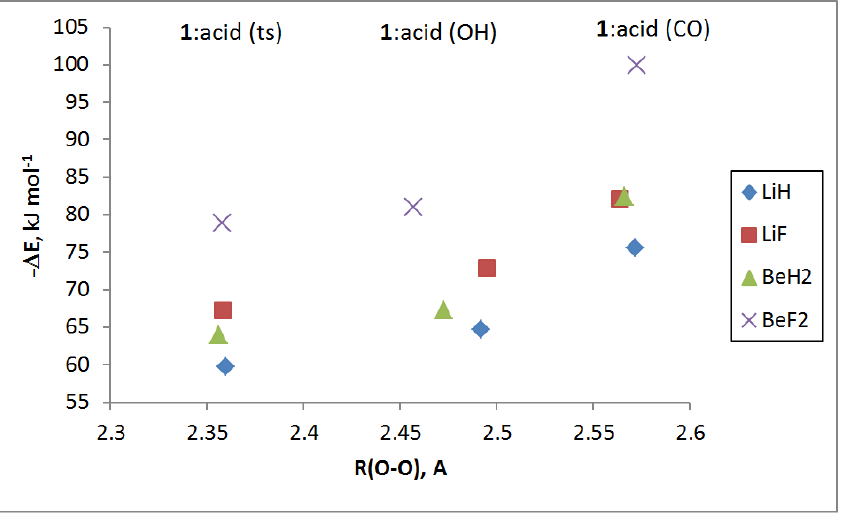
Figure 1. Binding energies versus the O–O distance for 1 :acid (OH), 1 :acid (ts), and 1 :acid (CO) complexes as a function of the acid.